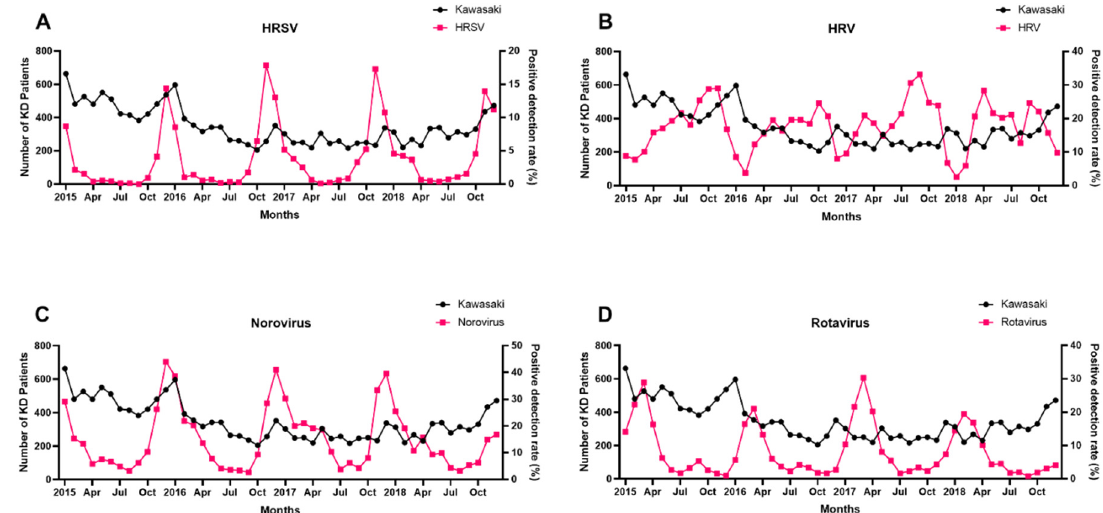
Figure 3. Relationship between PDR of ( A ) HRSV, ( B ) HRV, ( C ) norovirus, ( D ) rotavirus and incidence of KD during the study period.